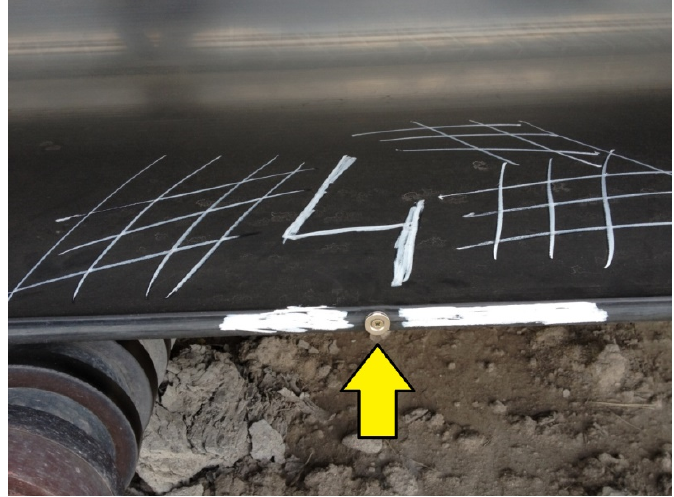
Figure 4. One of the marked neodymium magnets attached to the conveyor belt.